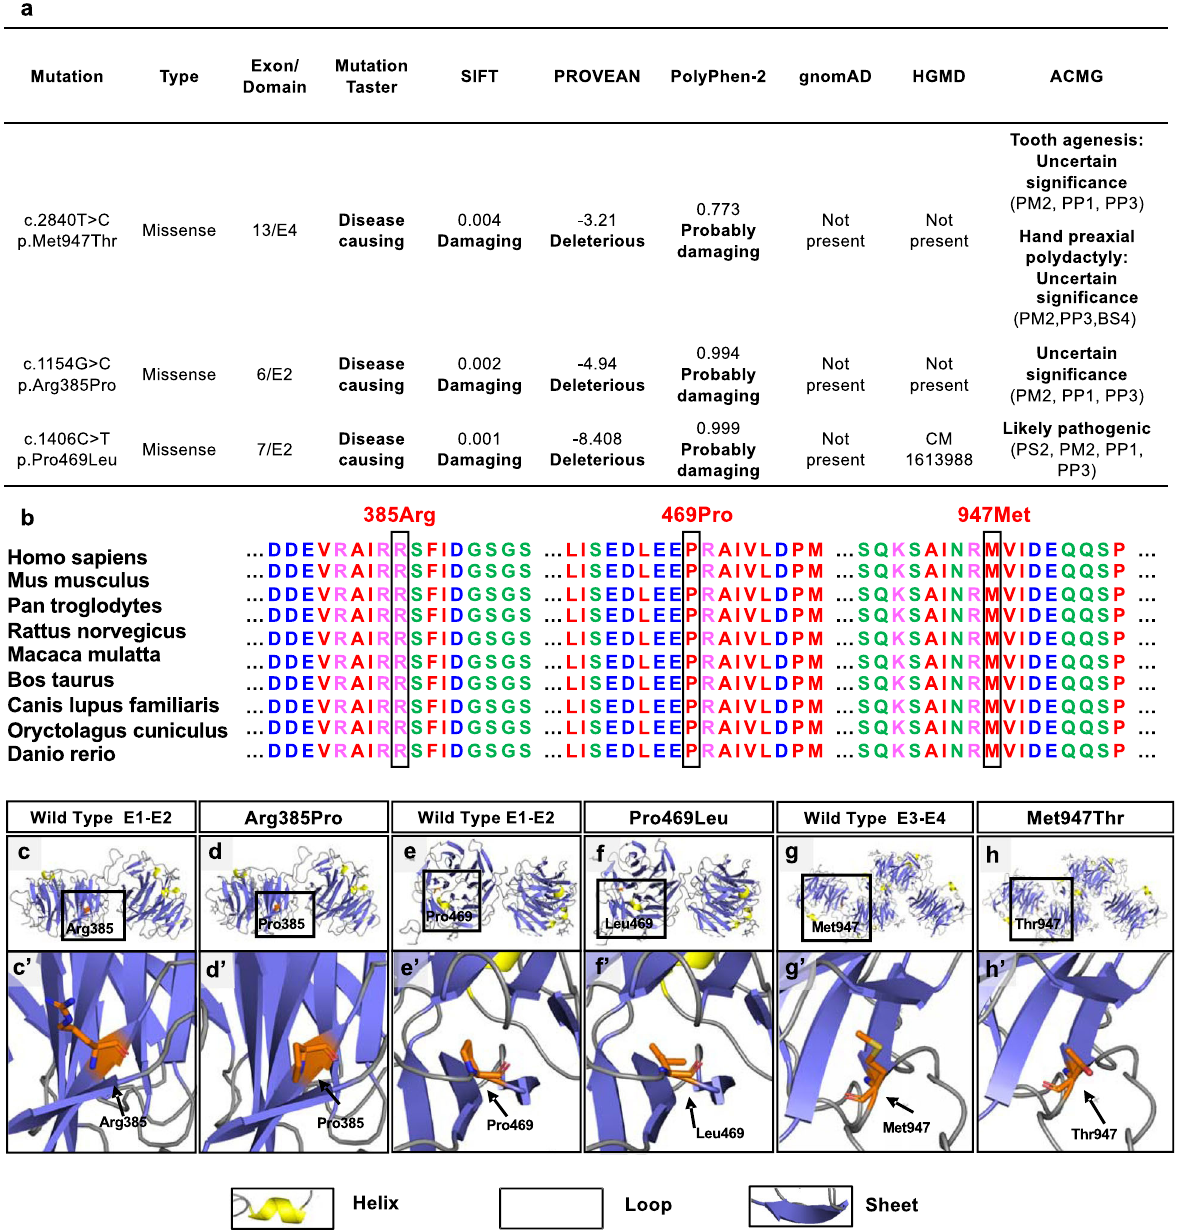
Fig. 2 Functional impact predictions, conservation analysis of LRP6 mutations, and structural modeling of the wild-type and mutated functional domains of LRP6 protein. a Functional impact prediction of two novel and one previously detected LRP6 mutations. b Conservation analysis of the affected amino acids in LRP6 protein. c – f Structural changes in the p.Arg385Pro and p.Pro469Leu mutants compared with that in wild-type E1 – E2. Dashed boxes denote the location of the Arg385 ( c ), Pro385 ( d ), Pro469 ( e ), and Leu469 residues ( f ). g , h Structural changes in the p.Met947Thr mutants compared with the wild-type E3 – E4. Dashed boxes indicate the location of the Met947 ( g ) and Thr947 ( h ). c ’– h ’ Higher magni fi cations of the above boxed regions surrounding the residues. Arrows indicate the wild-type ( c ’ , e ’ , g ’ ) and mutated residues ( d ’ , f ’ , h ’ ),